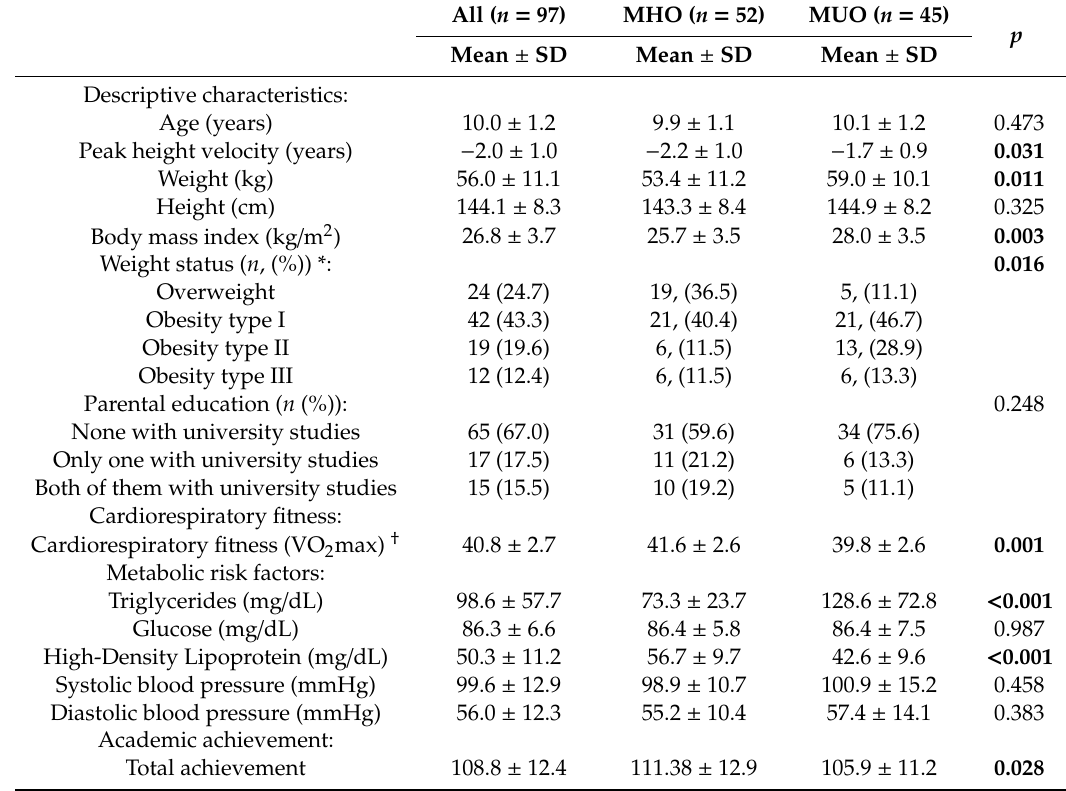
Table 1. Descriptive characteristics of the study sample ( n =